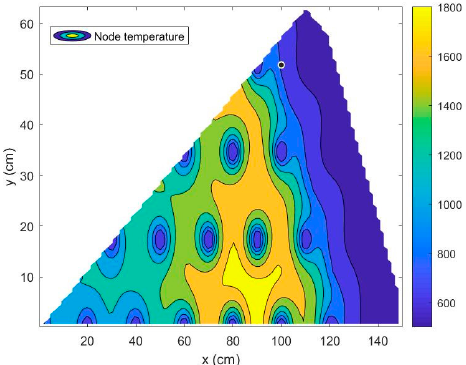
Figure 15. Temperature distribution of 1/12 core.